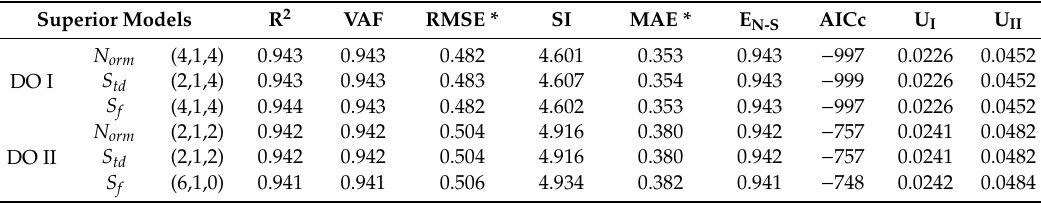
Table 4. Modeling evaluation indices of DO data.